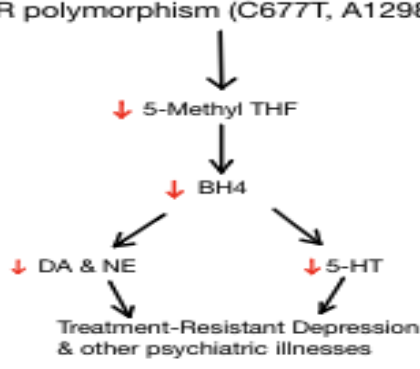
Figure 2. Downstream effects of MTHFR polymorphism and implications on neurotransmitter synthesis. MTHFR polymorphisms lead to decreased synthesis of L-methylfolate, leading to decreased levels of dopamine, norepinephrine and serotonin.